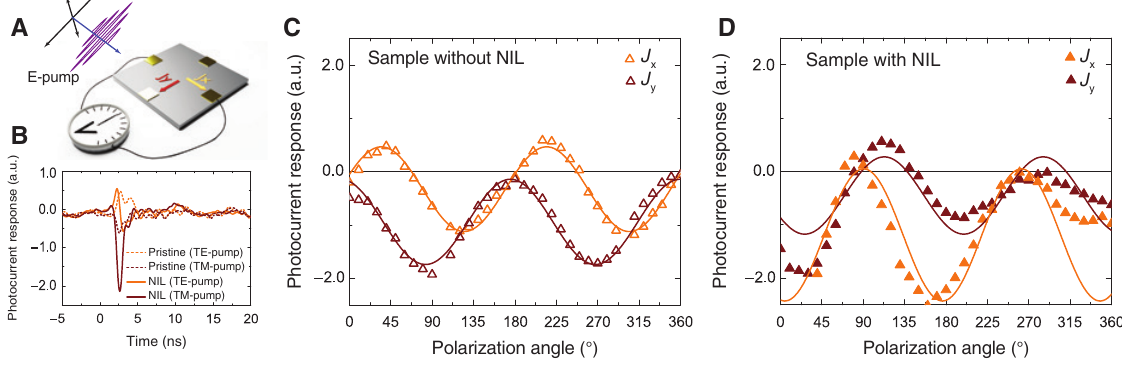
Figure 3: Photocurrent response. (A) A scheme of the photocurrent experiment. (B) Typical temporal profiles of photocurrent pulses induced in smooth and nanoimprinted perovskite films under excitation with different optical polarizations. Changes in the photocurrent with light polarization: (C) smooth perovskite sample; (D) NIL perovskite